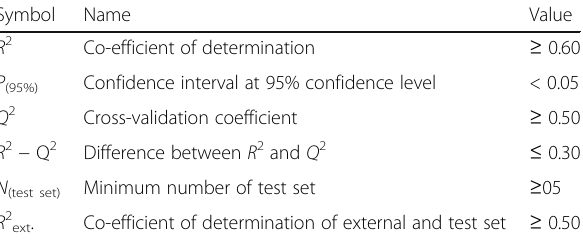
Table 1 The minimum recommended value for QSAR models